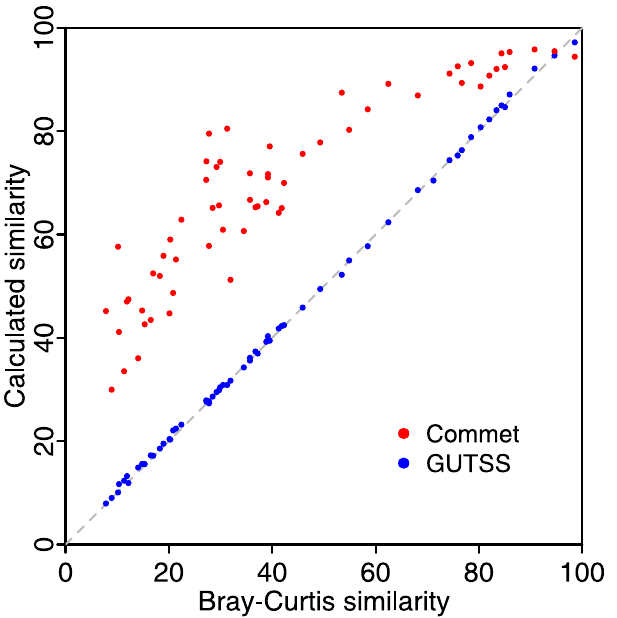
Fig 1. Simulated community analysis of GUTSS reveals sensitivity to relative abundance compared to Commet. Similarity scores for selected pairs of simulated communities (see Methods) using GUTSS and Commet are plotted against BC similarity. The BC index was calculated from the relative abundances used to construct the mock samples. The identity line (grey dashed line) is shown for reference.